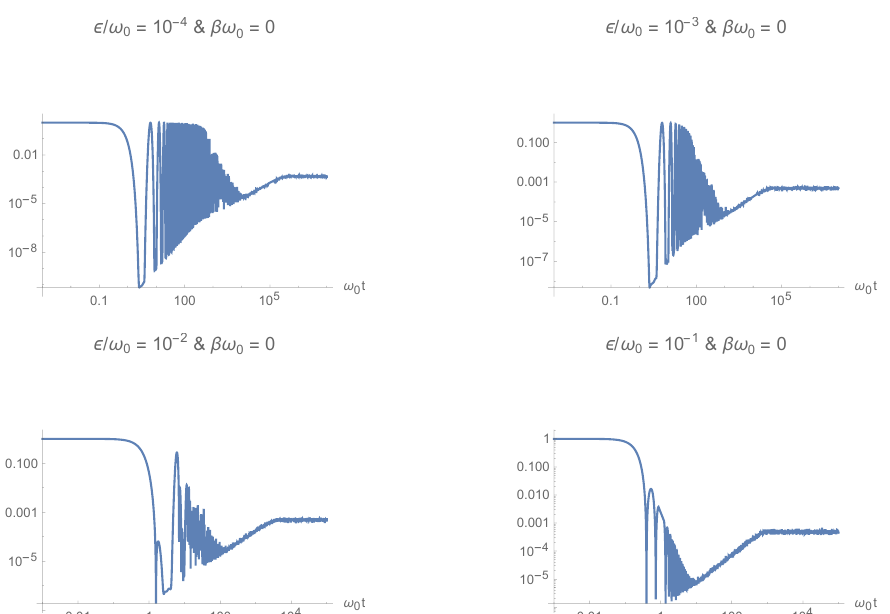
Figure 16 . The plots above depict the numerically averaged form factor on a Log-Log scale (averaged over 100 samples) at infinite temperature for a system of 11 fermionic oscillators coupled together by a ( 2 11 × 2 11 ) random GUE matrix for various values of (cid:15)/ω 0 ranging from 10 − 4 to 10 − 1